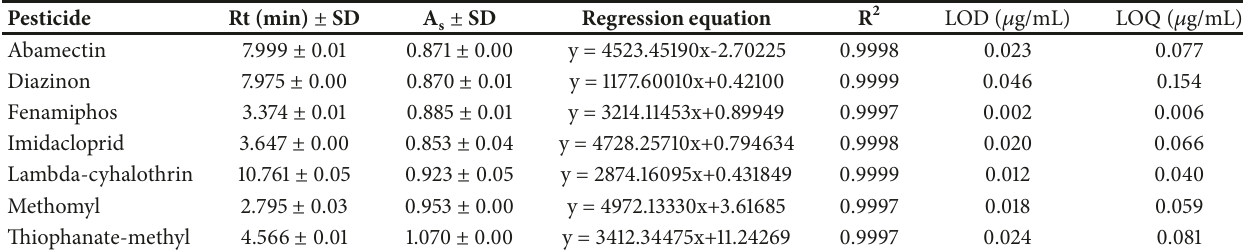
Table 3: Statistical data from regression analysis of different pesticides obtained from the study with analytical HPLC methods. ± SD Regression equation R 2 LOD ( 𝜇 g/mL) LOQ ( 𝜇 g/mL) Pesticide Rt (min) ± SD A s Abamectin 7.999 ± 0.01 0.871 ± 0.00 y = 4523.45190x-2.70225 0.9998 0.077 Diazinon 7.975 ± 0.00 0.870 ± 0.01 y = 1177.60010x+0.42100 0.9999 Fenamiphos 3.374 ± 0.01 0.885 ± 0.01 y = 3214.11453x+0.89949 Imidacloprid 3.647 ± 0.00 Lambda-cyhalothrin Methomyl 2.795 ± 0.03